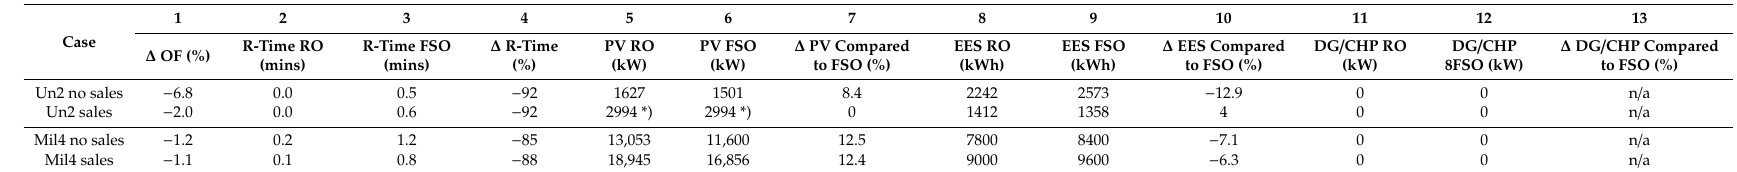
Table 3. Overview results for the sensitivity runs considering energy sales to the utility. OF: Objective Function; R-time: Run-time; RO: Representative Optimization approach; FSO: Full Scale Time-Series